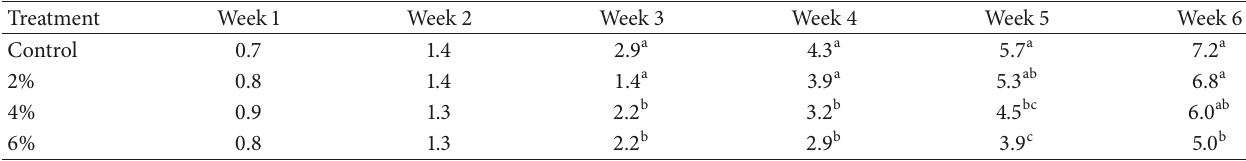
Table 1: Evolution of the average of physiological weight loss during storage.